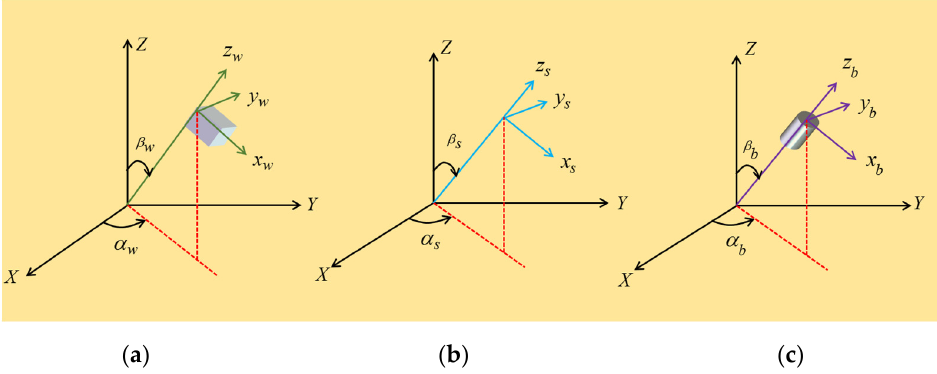
Figure 5. Reference coordinate system: ( a ) stratigraphic rectangular coordinate system; ( b ) in situ stress rectangular coordinate system; ( c ) borehole rectangular coordinate system.